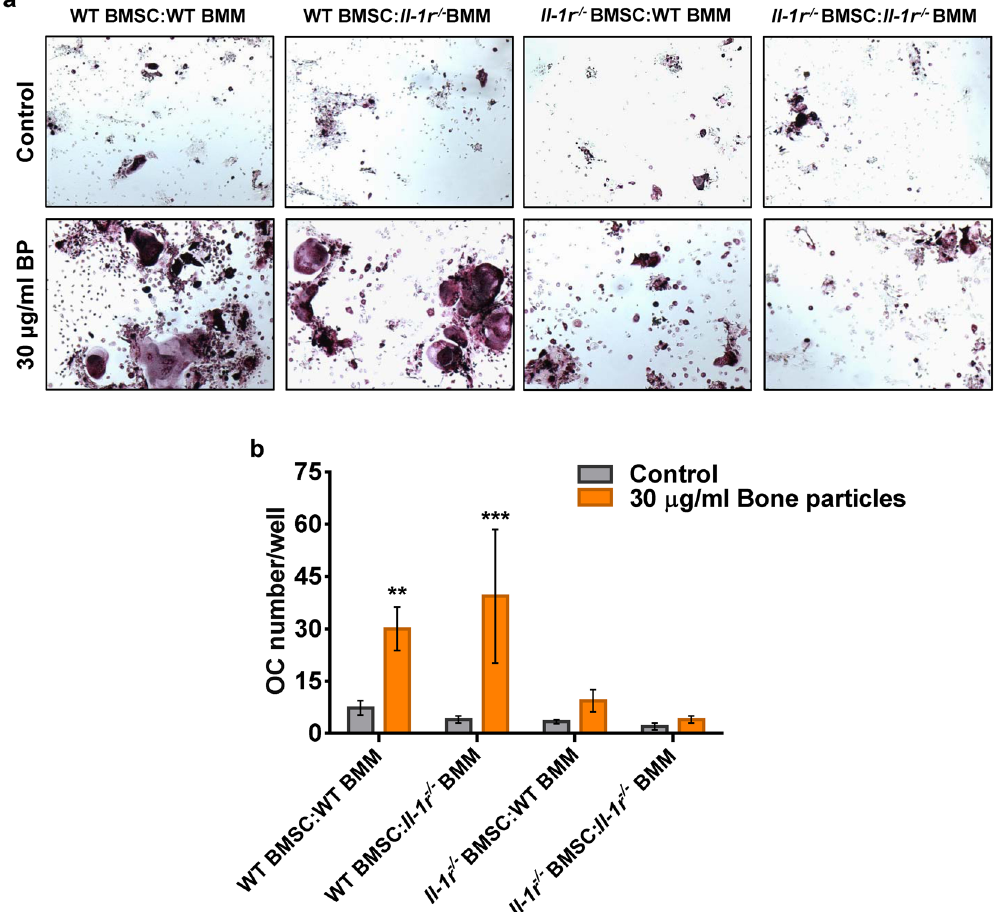
Figure 4. Bone matrix components induce OC formation in co-cultures. BMSC and BMM were obtained from WT or Il-1r − / − mice, and the co-cultures were set up for various cell combinations at a 1:1 ratio. After 2 days of co-cultures, bone particles (BP) were added and TRAP staining was performed at day 4 ( a ), and OC number was determined by counting multinucleated, TRAP-positive cells ( b ). ** p = 0.0084, *** p = 0.0004. Data are means ± SD of samples run in triplicates, and are representative of at least 2 independent experiments. p values correspond to significant differences relative to WT BMSC:WT BMM (control).